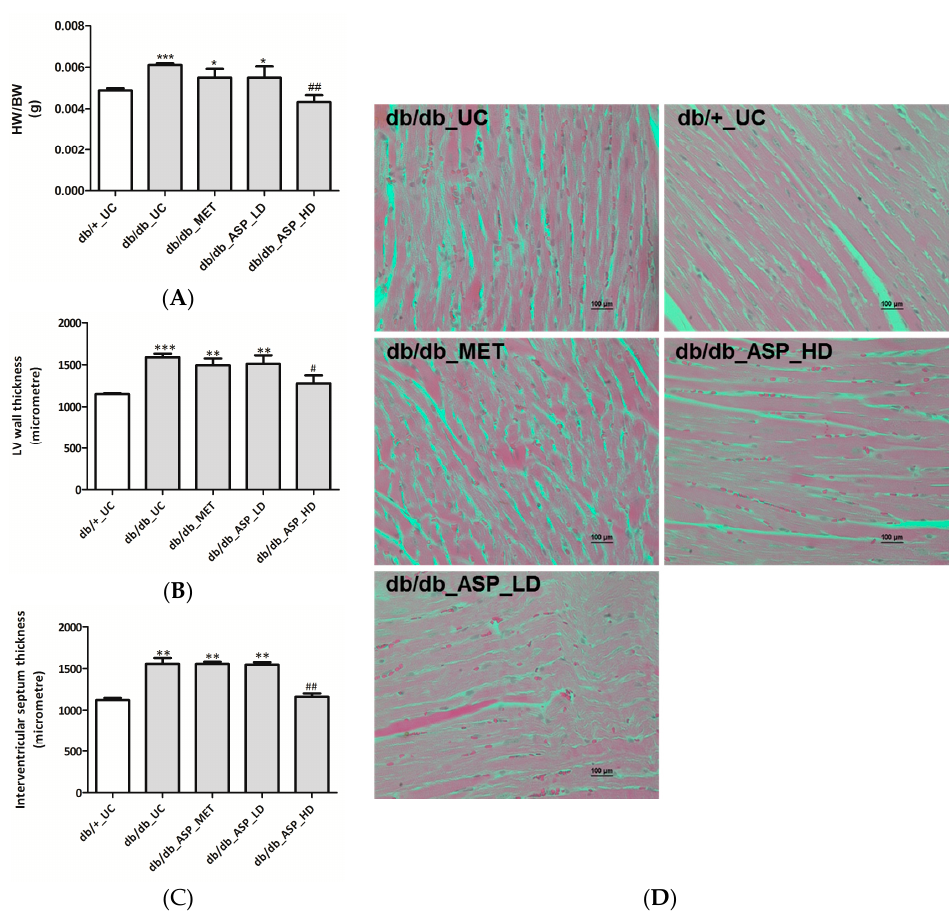
Figure 4. Aspalathin (ASP) prevented hyperglycemia-induced cardiac muscle structure modifications associated with hypertrophy in diabetic mice. ( A ) Heart weight (HW) to body weight (BW) ratio; ( B ) left ventricular (LV) wall thickness; ( C ) interventricular septum thickness; and ( D ) photomicrographs of cardiac remodelling. Results are expressed as the mean ± SEM and each treatment group contained six mice. * p ≤ 0.05, ** p ≤ 0.001, *** p ≤ 0.0001 vs. untreated nondiabetic mice ( db / + _UC), # p ≤ 0.05, ## p < 0.001 vs. untreated diabetic mice ( db / db _UC). db / db _MET: diabetic mice treated with metformin (150